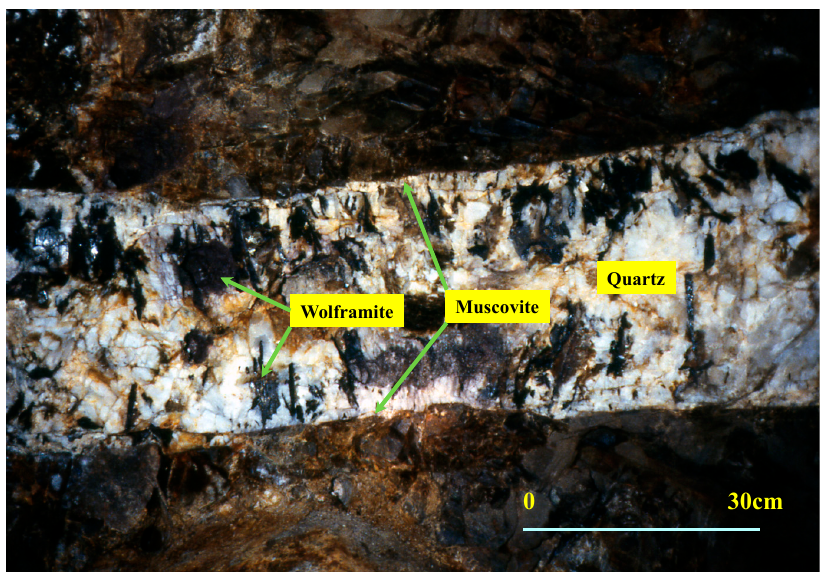
Figure 2. A typical wolframite-bearing quartz vein on the adit roof in the Takatori mine. The vein (No. 8 vein on level − 4L, 57 m above sea level) is composed of quartz and wolframite with minor amounts of cassiterite, pyrite, and muscovite. Muscovite is mostly found in the vein/wall-rock boundary.